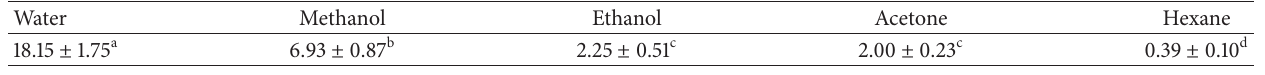
Table 1: Percentage yield of extracts obtained with different solvents of the polyherbal formulation “ImmuPlus.” Water Values with different letters are statistically different ( P ≤ 0.05). Table 2: Analysis of antioxidant properties and polyphenol and flavonoid contents of different extracts of the polyherbal formulation “ImmuPlus.”